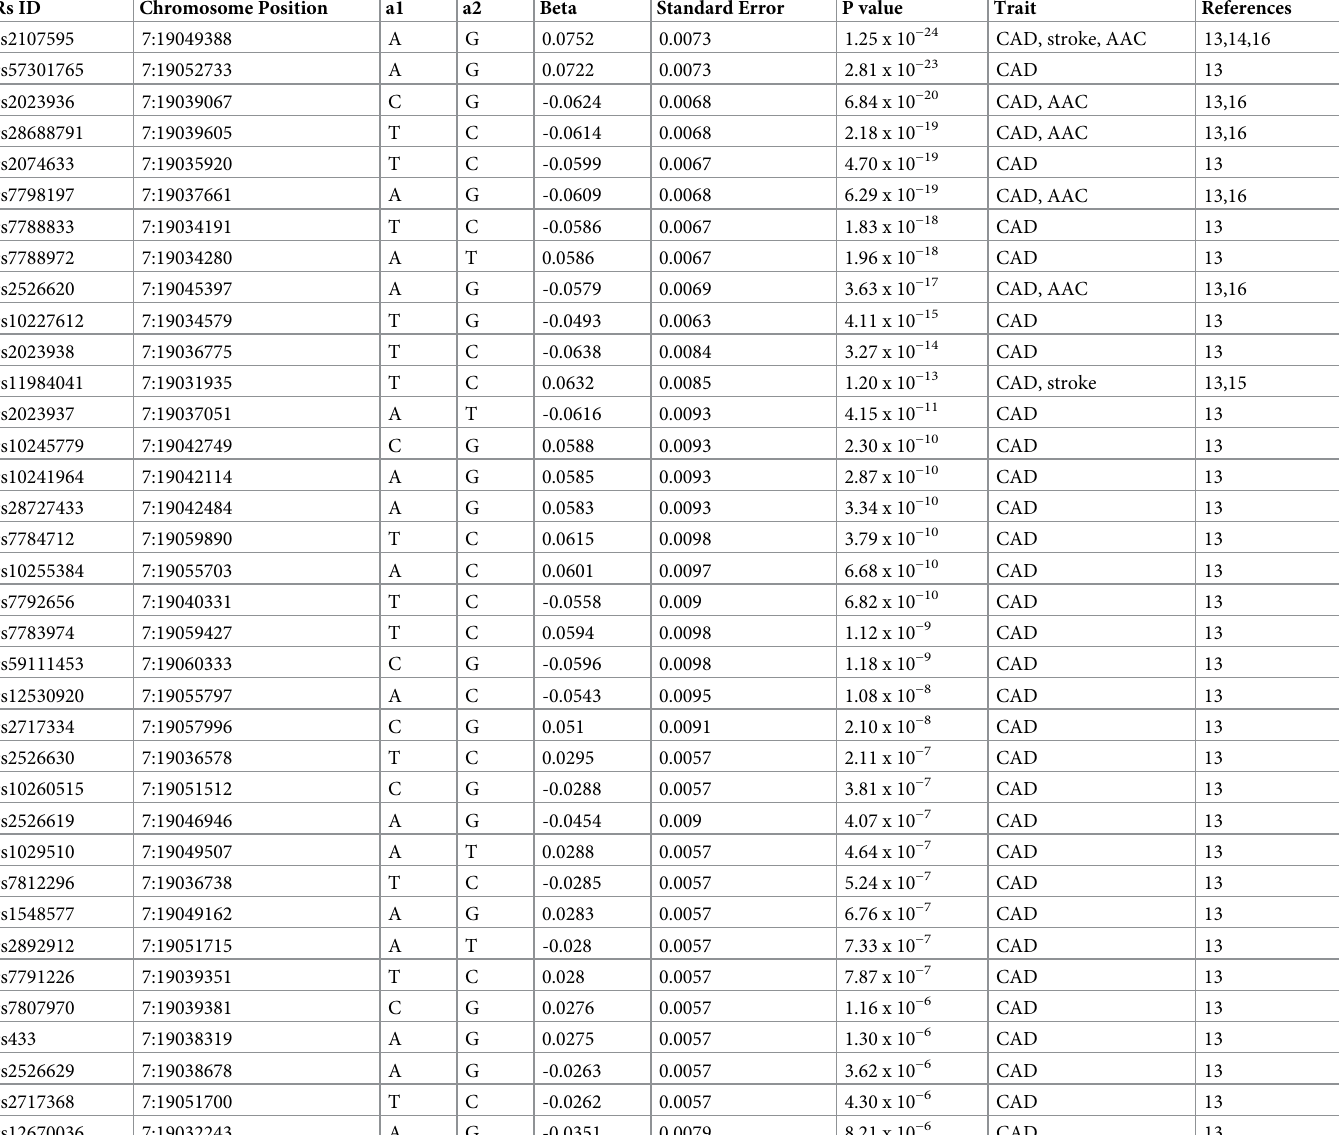
Table 1. SNPs associated with CAD, stroke, atherosclerotic aortic calcification (AAC) in the HDAC9 -associated risk locus and its vicinity. SNPs correspond to those presented in Fig 1 and are ranked by P value. SNPs were obtained from published reports [13–16] and public databases, including the GWAS catalog [25] and PhenoScan- ner [26]. None of the SNPs had a stronger beta and/or smaller P value for AAC or stroke than for CAD, and therefore the beta, standard error and P value listed in Table 1 are for